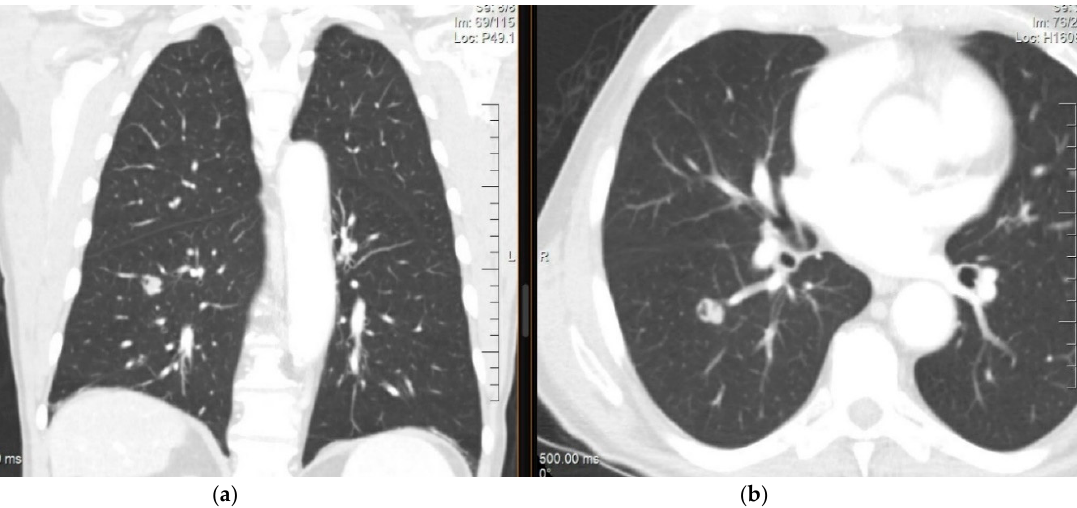
Figure 1. CT of the chest ( a ) coronal view and ( b ) axial view showing a nodule in the right lower lobe measuring 1.5 cm, lobulated and cavitated. The lesion was biopsied and revealed an adenocarcinoma with cytomorphology and an immunoprofile that was consistent with a colorectal primary.